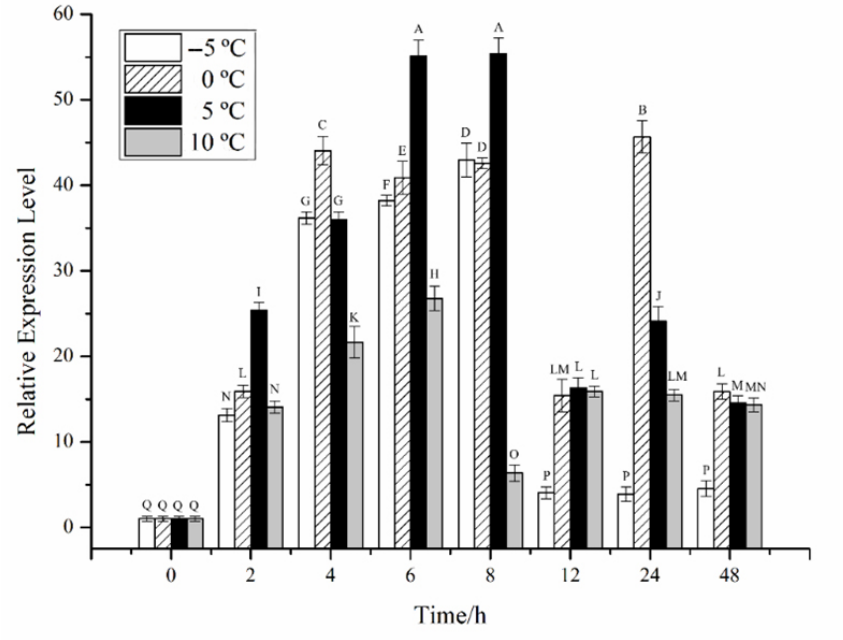
Figure 3. Relative expression of the CiPlant-CRY1 at different temperatures for different times. Standard error bars are shown, n = 3. Different capital letters indicate significant differences between different treatments ( p <